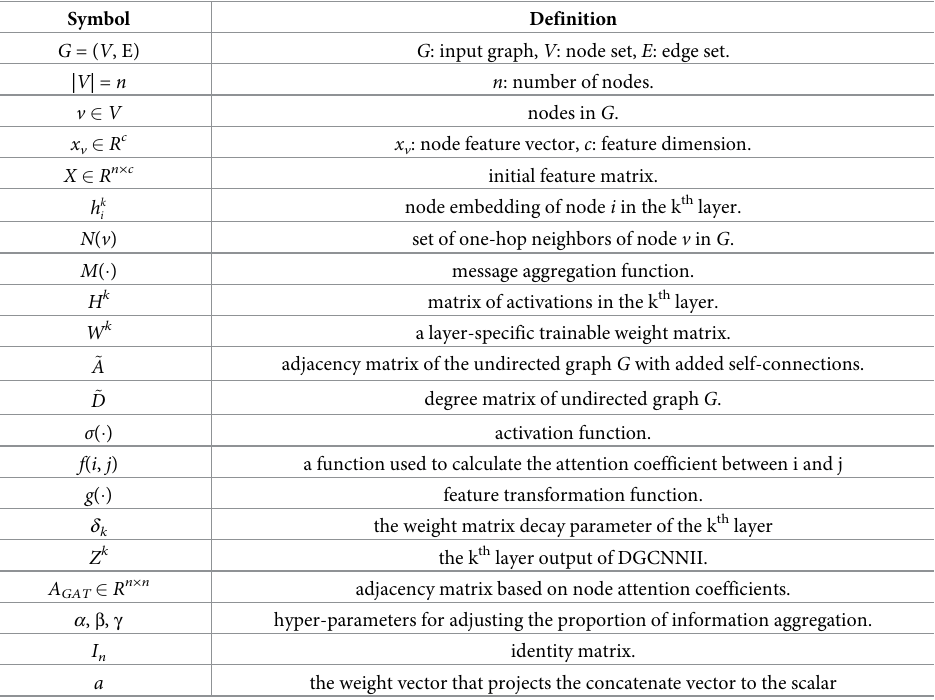
Table 2. Table of symbols used in this